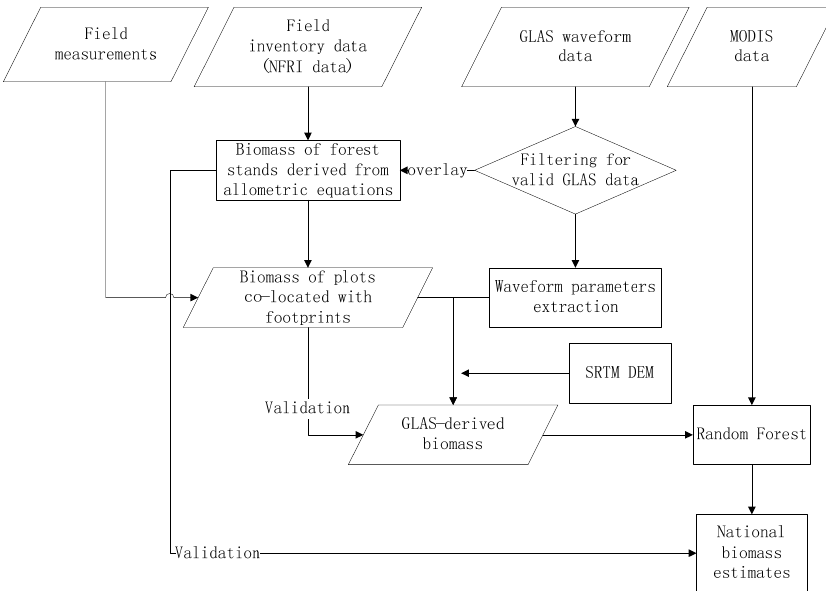
Figure 3. Processing flow of national biomass estimation from MODIS, GLAS, and field